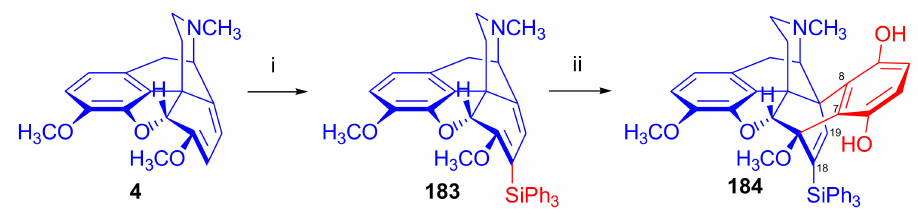
Figure 49. Synthesis of 18-triphenylsilyl-substituted 6,14-ethenomorphinan derivative. Reagents and conditions : (i): 2 equiv. BuLi, 2 equiv. TMEDA, 10 equiv. Ph 3 SiCl, 1. − 78 ◦ C, 30 min, 2. room temperature 12 h; (ii): 10 equiv. 1,4-benzoquinone, toluene, reflux, 4